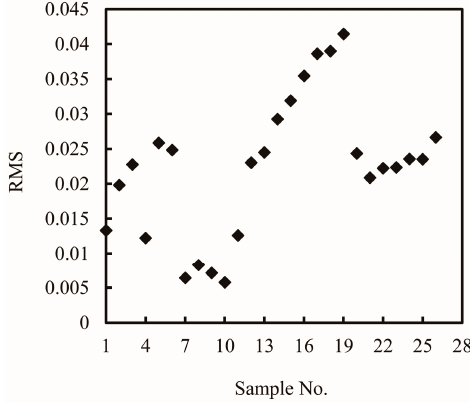
Figure 3. RMS errors from comparisons between experimental data and predicted results.